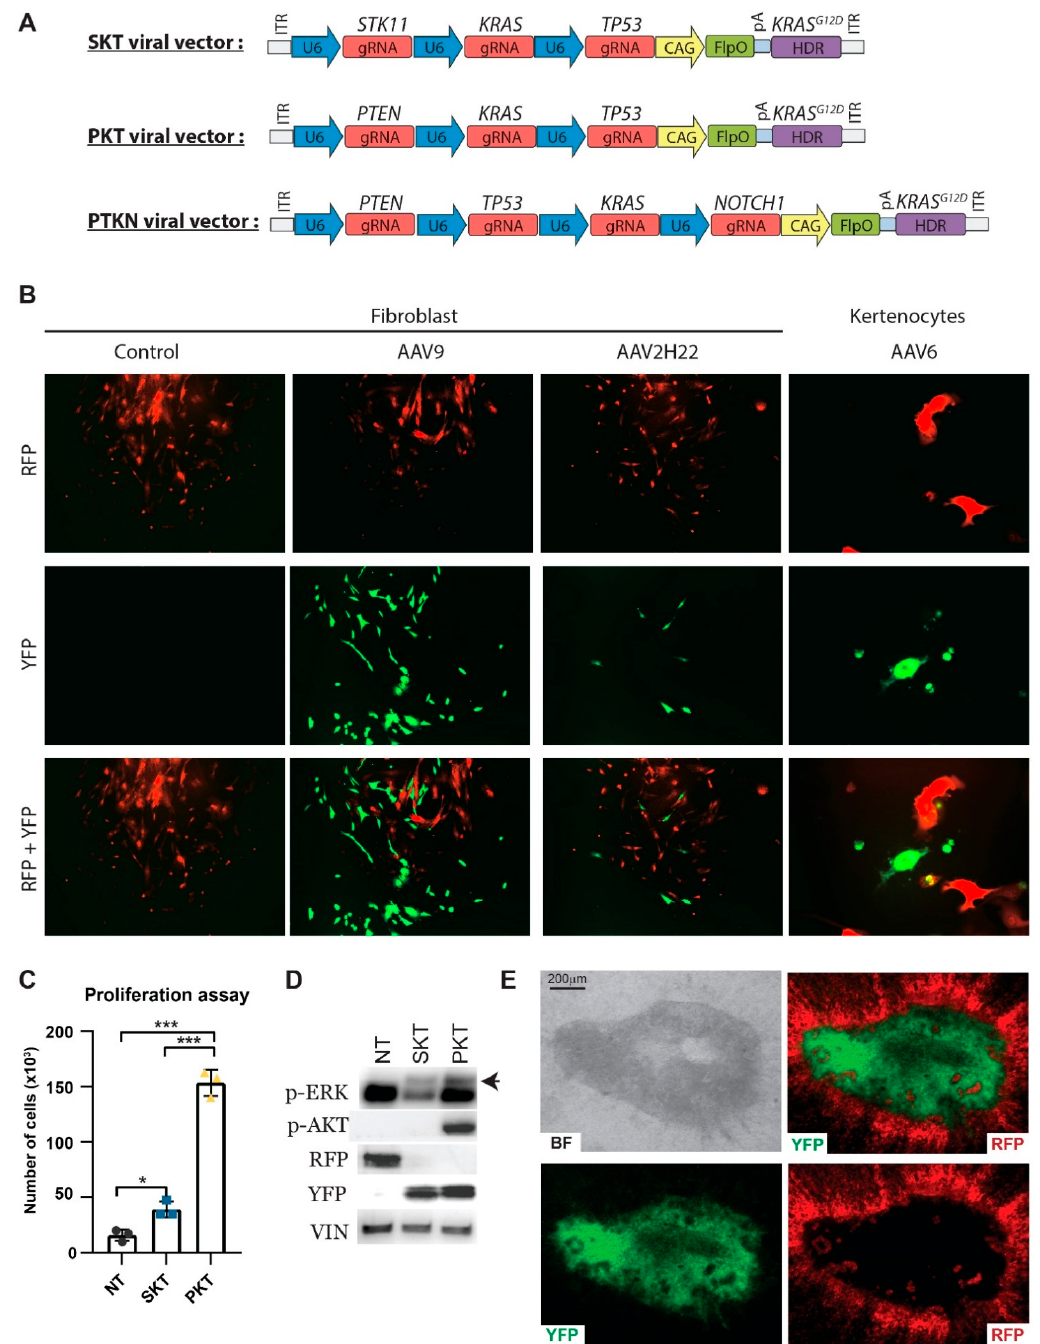
Figure 3. CRISPR-induced mutation in vitro. ( A ) Overview of the AAV viral vectors containing the FlpO gene used to activate the Cas9 expression, a KRASG12D repair template and sgRNAs against the following target genes: STK11, KRAS, TP53 (SKT). PTEN, TP53, KRAS (PKT). PTEN, TP53, KRAS, and NOTCH1 (PTKN). ( B ) Primary fibroblasts and keratinocytes were transduced with AAV particles, containing sgRNAs and FlpO expression. Transformed cells turn from red to yellow upon FlpO recombination. Images were taken after one passage of the cells. ( C ) Proliferation assay on non-treated, SKT_AAV2H22 or PKT_AAV9-treated Cas9 fibroblasts. Cells had undergone five passages before the proliferation was measured. * p < 0.05, *** p < 0.001. ( D ) Western blot on protein lysate from the proliferation assay. Black arrow marks p-ERK. Vinculin (VIN) was used as loading control. ( E ) Image 6 weeks after SKT_AAV2H22-treated air–liquid interface (ALI) Cas9 pig pseudostratified, ciliated, columnar tracheobronchial epithelial cells. Western Blot Images can be found in Figure